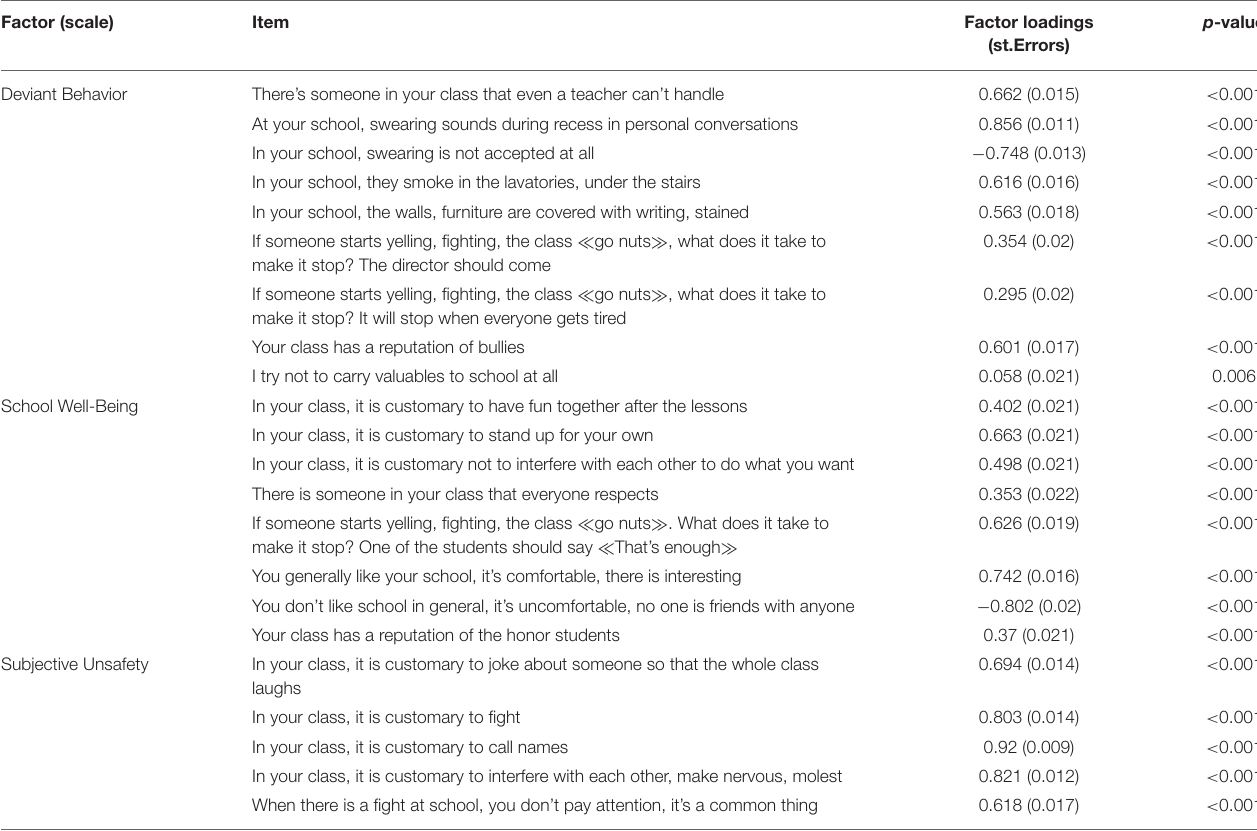
TABLE 2 | Factor loadings in the model. Factor (scale) Item